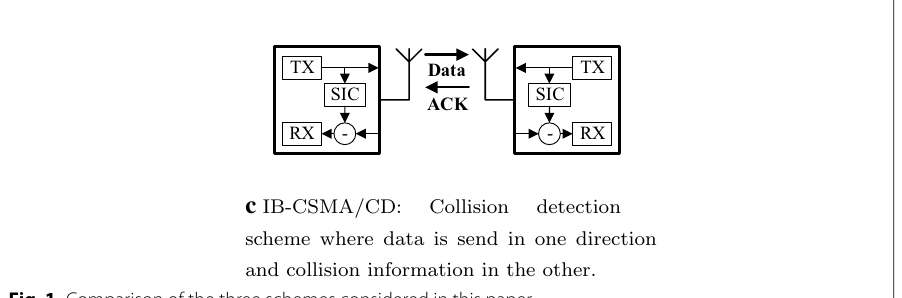
scheme where data is send in one direction and collision information in the other. Fig. 1 Comparison of the three schemes considered in this